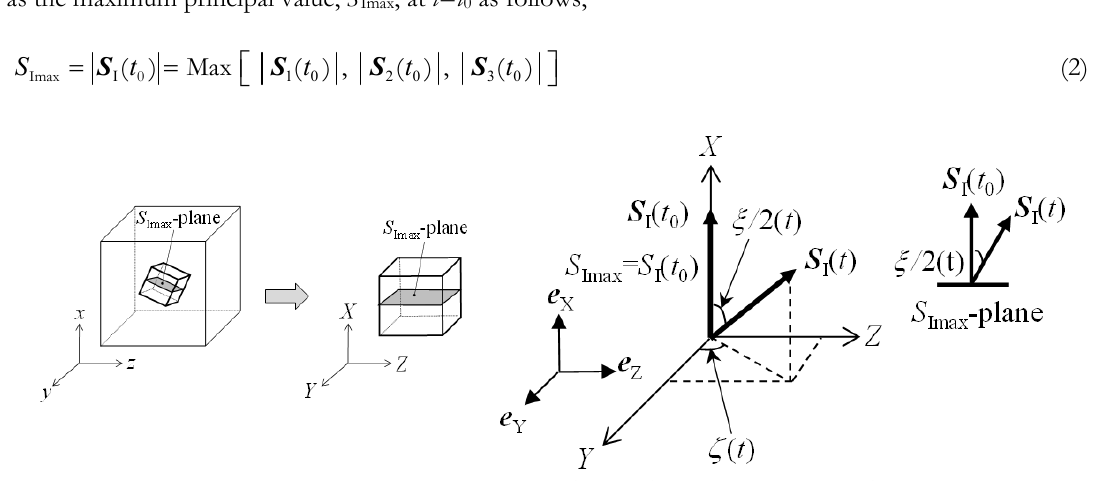
Figure 2: Definition of principal stress and strain directions in XYZ